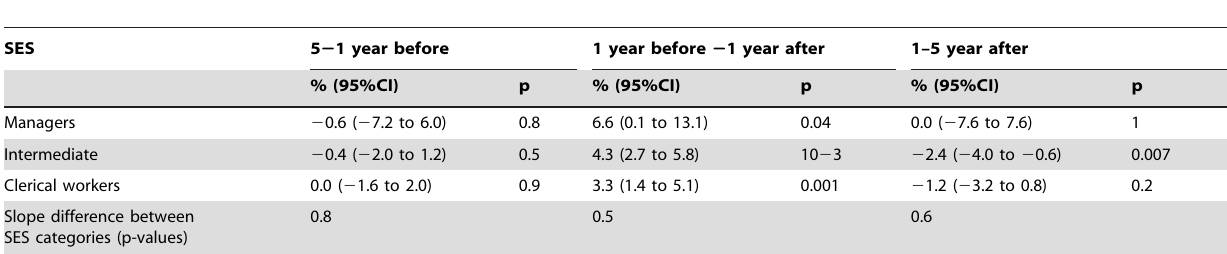
Table 5. Change in the proportion of heavy drinkers during 3 periods surrounding retirement by SES group in women (from generalised estimation equations